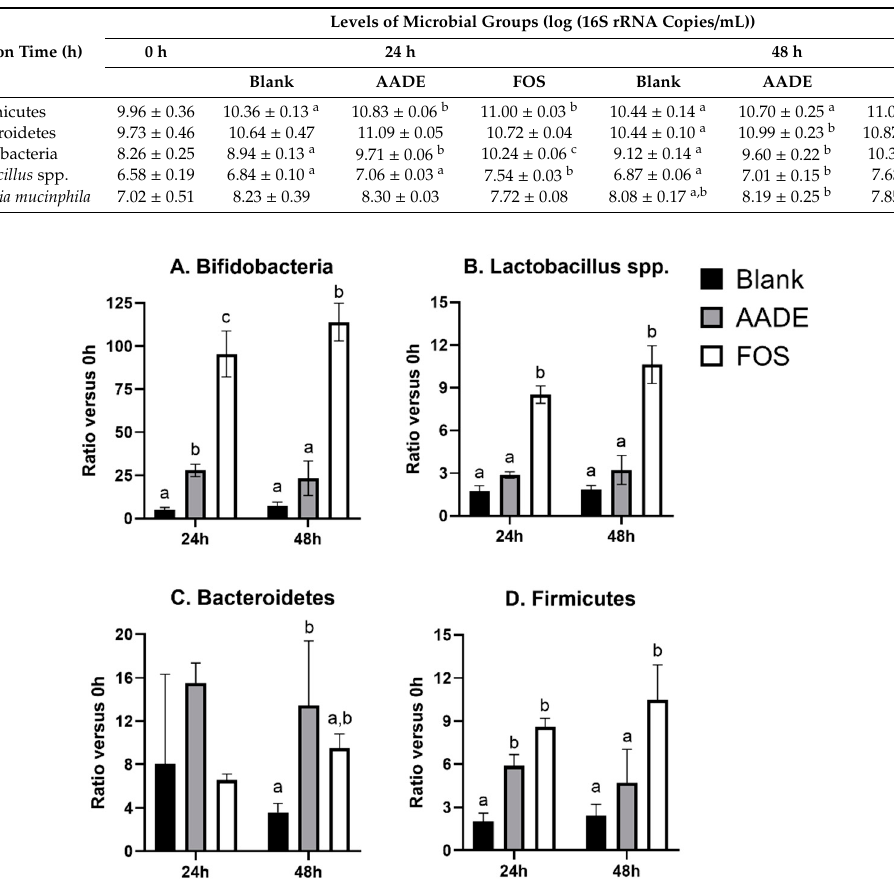
Figure 1. Mean ( ± standard deviation) ratios of ( A ) Bifidobacterium spp., ( B ) Lactobacillus spp., ( C ) Firmicutes, and ( D ) Bacteroidetes levels after 24 h or 48 h of treatment of a simulated colonic microbiota with 5 g/L AADE (artichoke aqueous dry extract) or FOS (fructo-oligosaccharides) versus the initial levels (24 h/0 h or 48 h/0 h, respectively) as measured via quantitative polymerase chain reaction (qPCR). For each microbial group and within each time point (24 or 48 h), a bar indicated with a different letter (a, b, or c) indicates a statistical difference between AADE, FOS, and/or the blank at a given time point, as tested with a two-way ANOVA with post-hoc Tukey test ( p < 0.05). In contrast, when at least one letter is shared between two bars, there was no significant between these treatments.